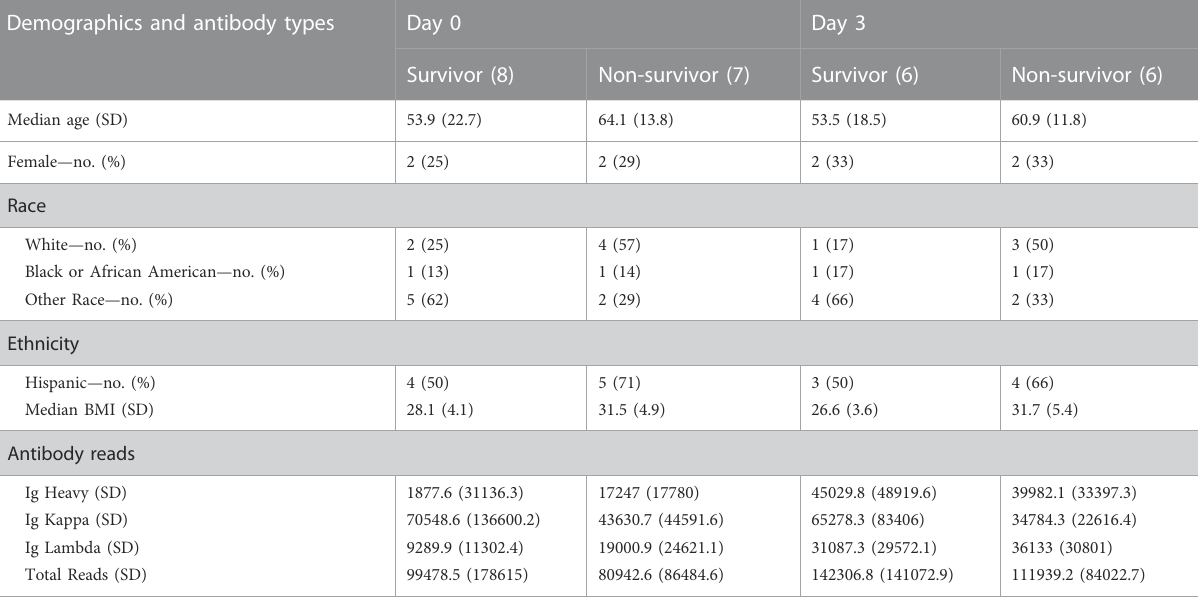
TABLE 1 Demographic data and antibody types per group (survivor vs non-survivor) at ICU Day 0 and ICU Day 3. Demographics and antibody